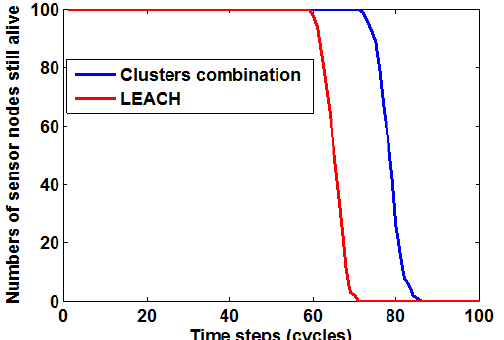
Figure 8. log(mean) dispersion of reference and log dispersion original data sets.